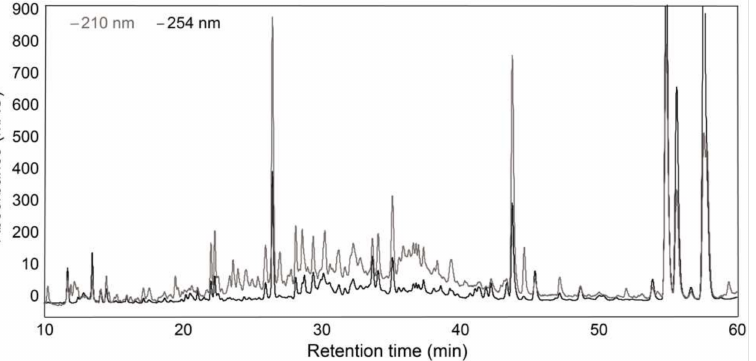
Figure 2. HPLC-PDA chromatogram of the crude acetonitrile extract of E. galeata (grey: 210 nm, black: 254